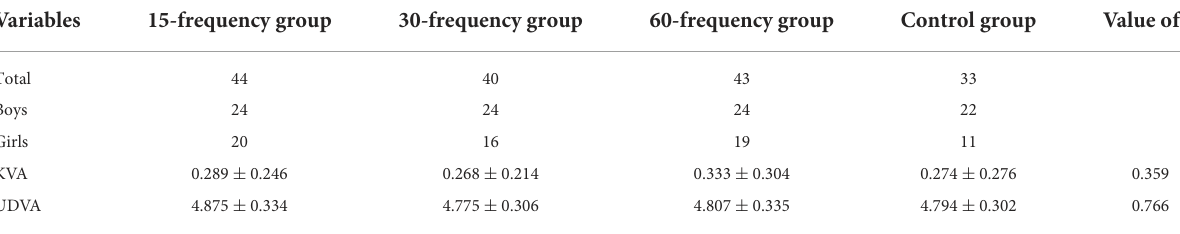
TABLE 1 Participants demographic characteristics ( N = 160, M ±